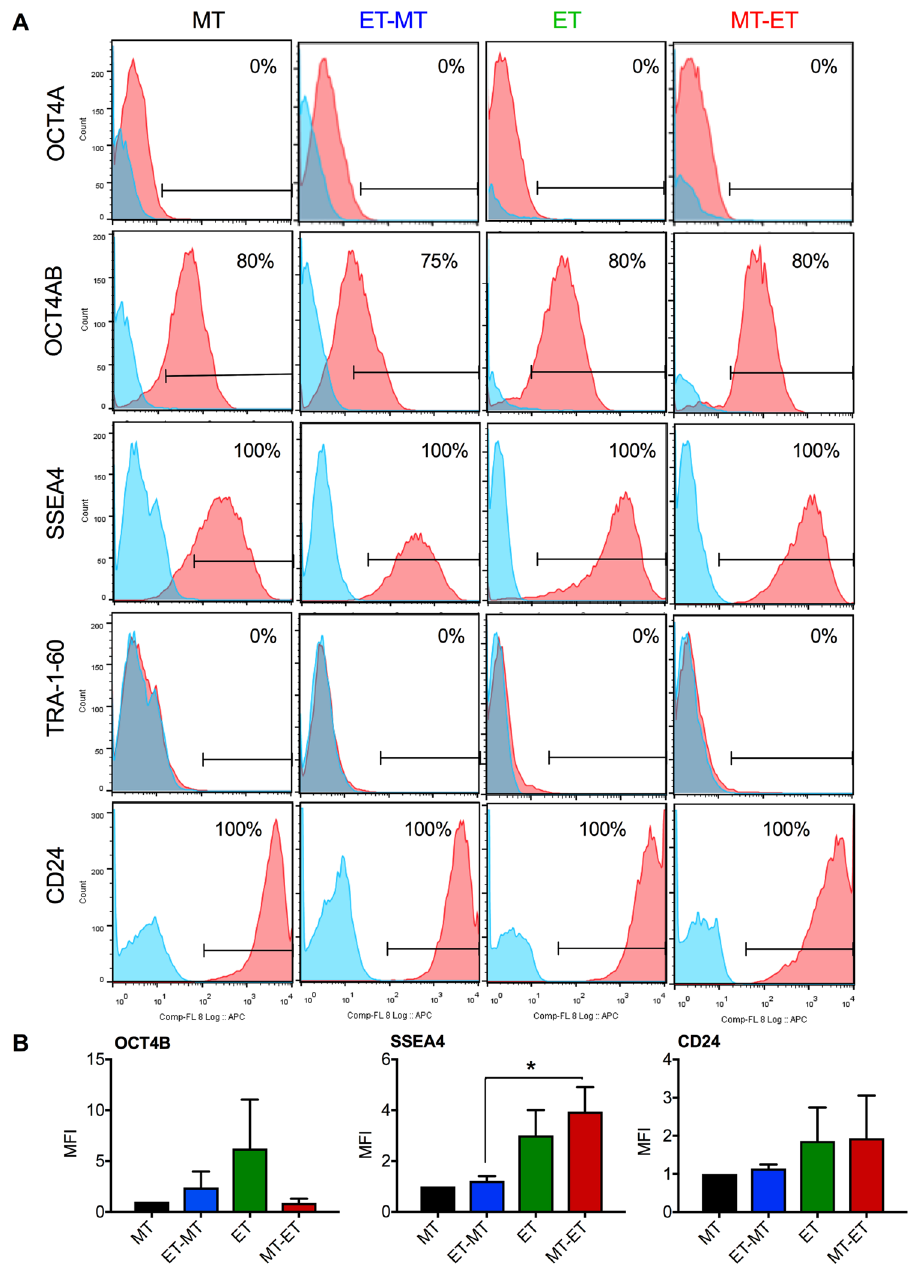
Figure 3. Immunophenotype of RS-hAFSCs cultured in in different conditions. ( A ) Flow cytometry to show the expression of OCT4-A, OCT4-B, SSEA4, Tra1-60, and CD24. Isotype control in blue. ( B ) Relative mean fluorescence intensity (MFI) for the different groups (measured from 10,000 cells and using the same antibody concentration, experimental conditions and cytometer settings for all groups). Data represent mean ± SEM. SEM: standard error of the mean. ** P <